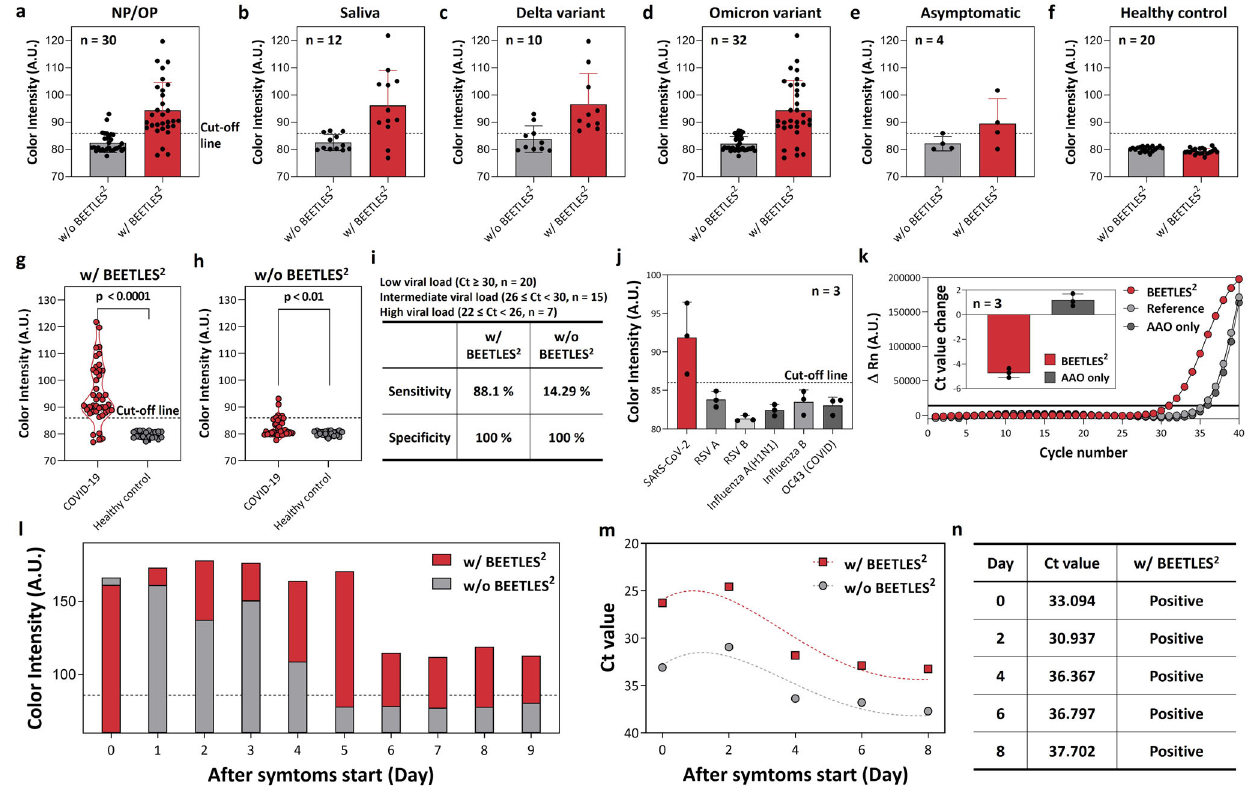
Fig. 4 | Clinical performance validation. Clinical samples include COVID-19 patients ( n =42) and healthy controls ( n =20). We included low-viral patient sam- ples(Ct ≥ 30, n